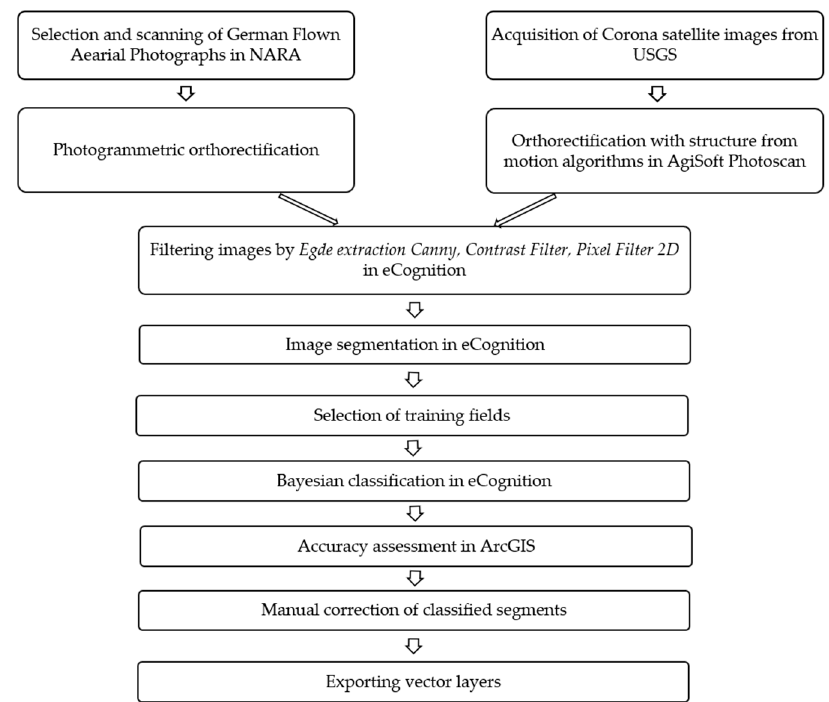
Figure 3. Flowchart showing the processing of Corona images and German Flown Aerial Photo- graphs.